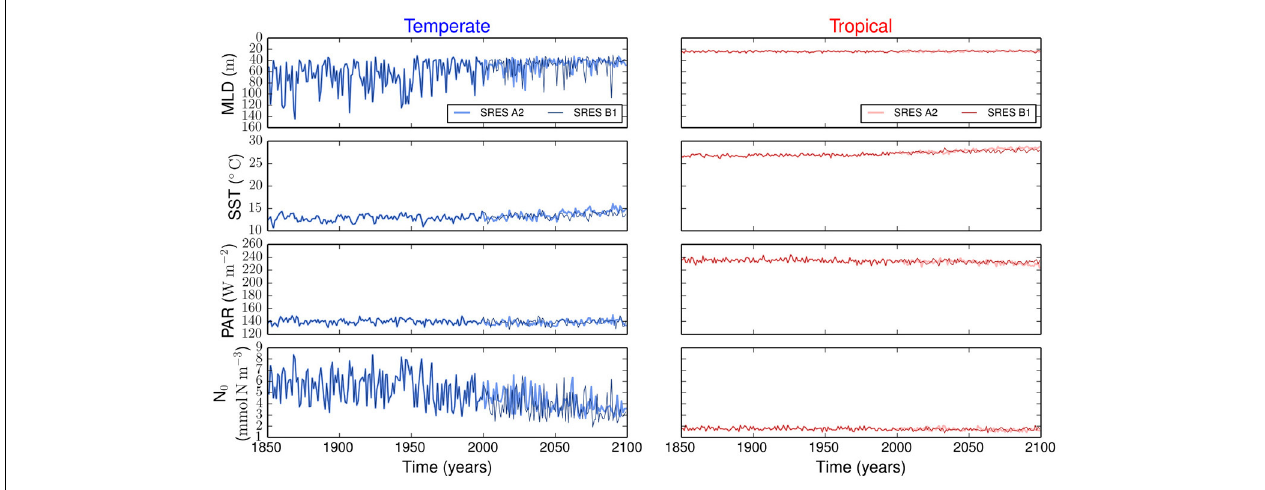
FIGURE 1 | Environmental forcing for temperate and tropical regions under the SRES A2 and the SRES B1 emission scenarios. MLD is the mixed layer depth, PAR is the